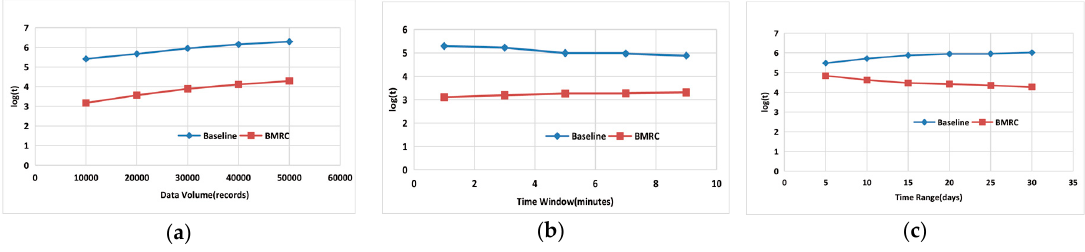
Figure 10. Comparison study for BMRC: ( a ) Varying Data Volume; ( b ) Varying Time Window; ( c ) Varying Time Range.